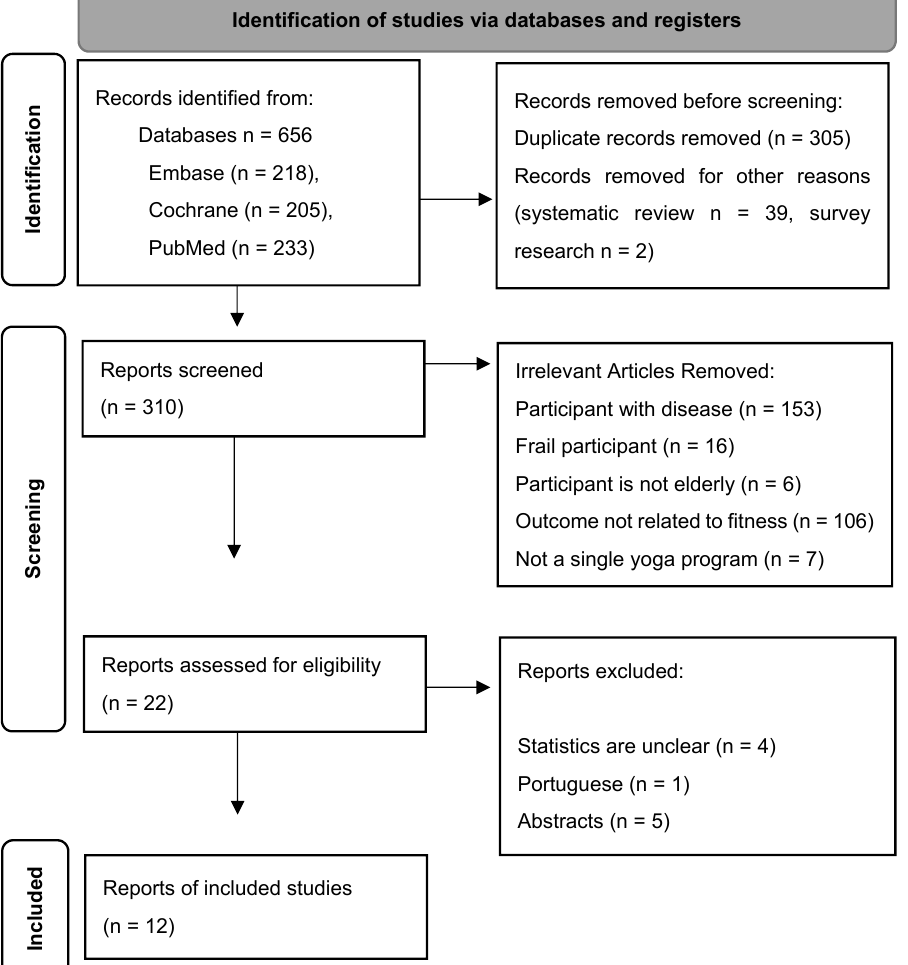
Figure 1. Elimination process of the articles selected for the review (PRISMA 2020 flow diagram